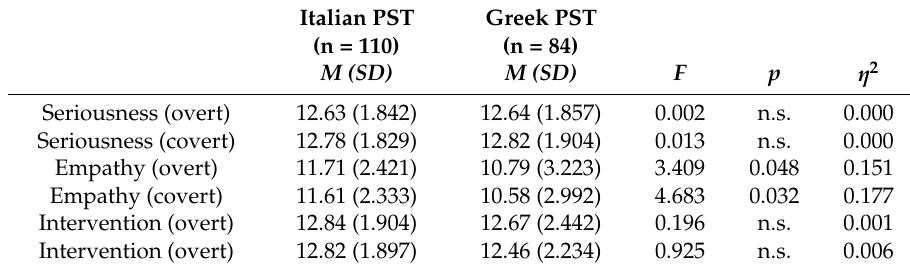
Table 2. Attitude toward bullying. Comparison between Italian and Greek PST (one-way ANOVA) (Range: 3–15).